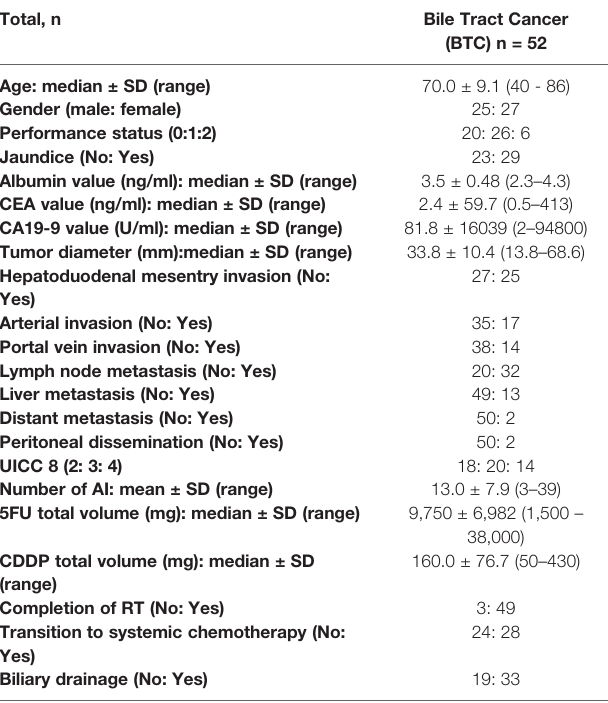
TABLE 1 | The baseline characteristics and treatment content of the patients and lesions. Total,